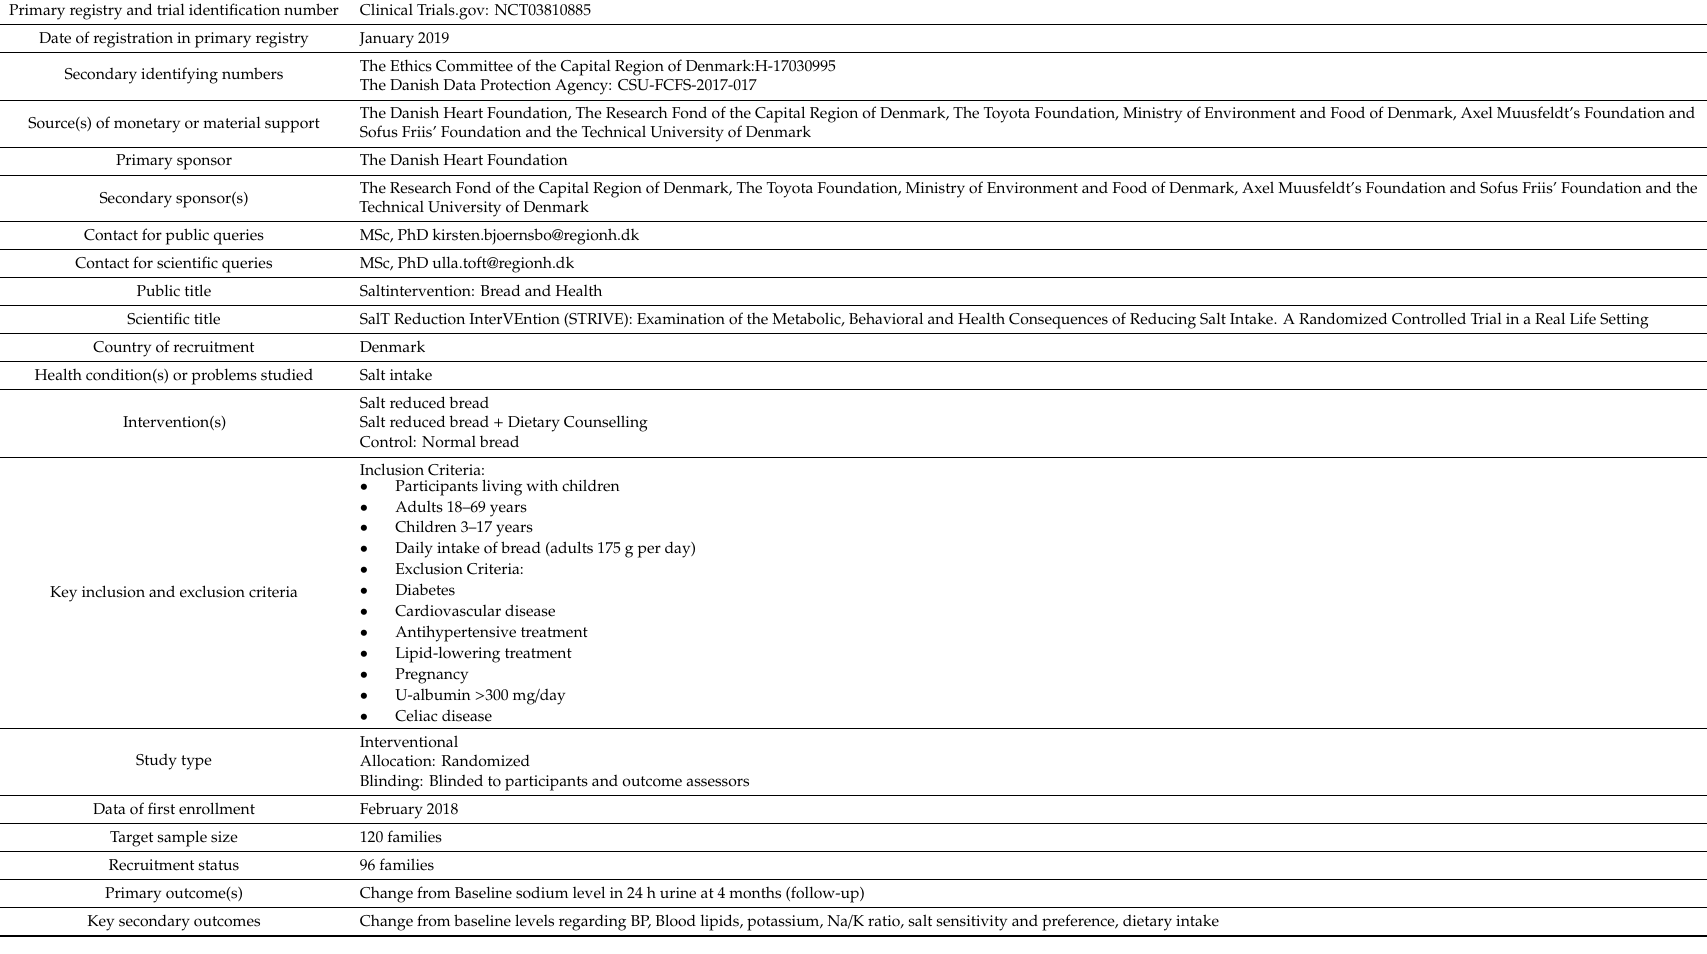
Table A1. Trial registration